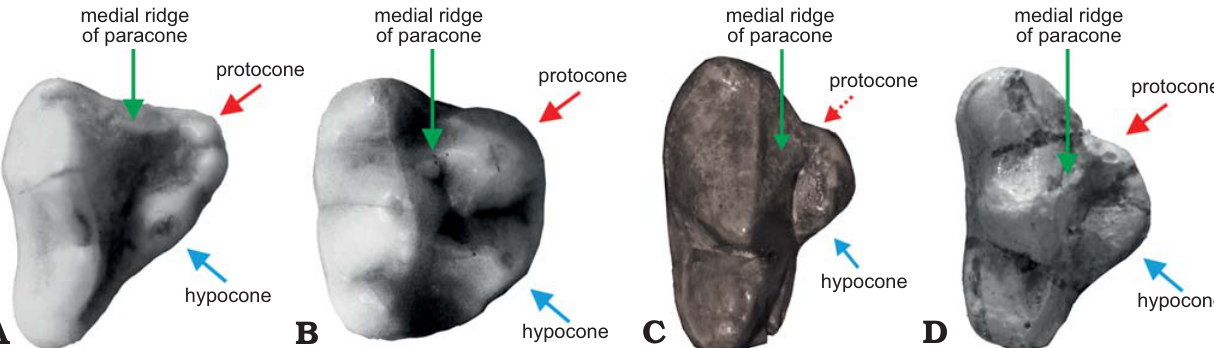
Fig. 4. Occlusal views of P4 inner lobe structure of Musteloidea and Ursidae, showing the homology of inner lobe cusps. A . Meles leucurus Hodgson, 1847 (IOZ08129), Recent, China. B . Procyon lotor (Linnaeus, 1758) (IVPP OV1551), Recent, zoo specimen. C . Plithocyon teilhardi (Colbert, 1939) (AMNH FM26594) from the Tunggur Formation, Middle Miocene; the dashed line indicates that the protocone is absent in this species. D . Ailurarctos yuanmouensis Zong, 1996 (IVPP RV97001, cast) from Yuanmou, Yunnan Province. Not to